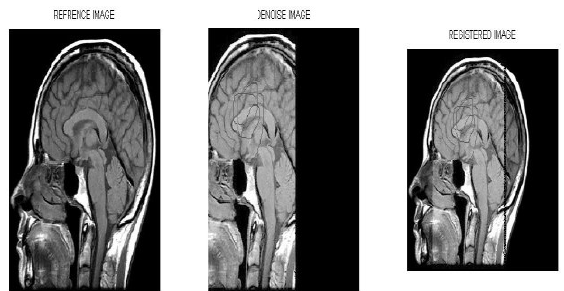
Fig 9. Image Registration for Head CT with Denoise effect Horizontal movement: 01,Vertical movement: 50, Rotated angle: 0ᴼ Table 4. Head CT: Comparision of registered image with and without denoising effect Sr.